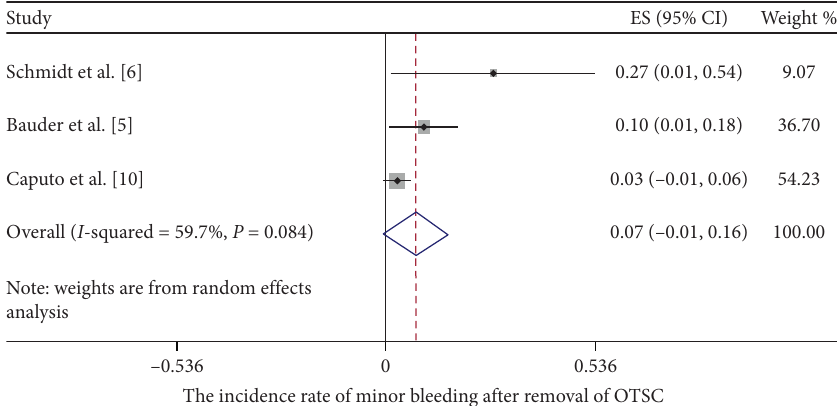
Figure 8: The pooled incidence rate of minor bleeding after OTSC